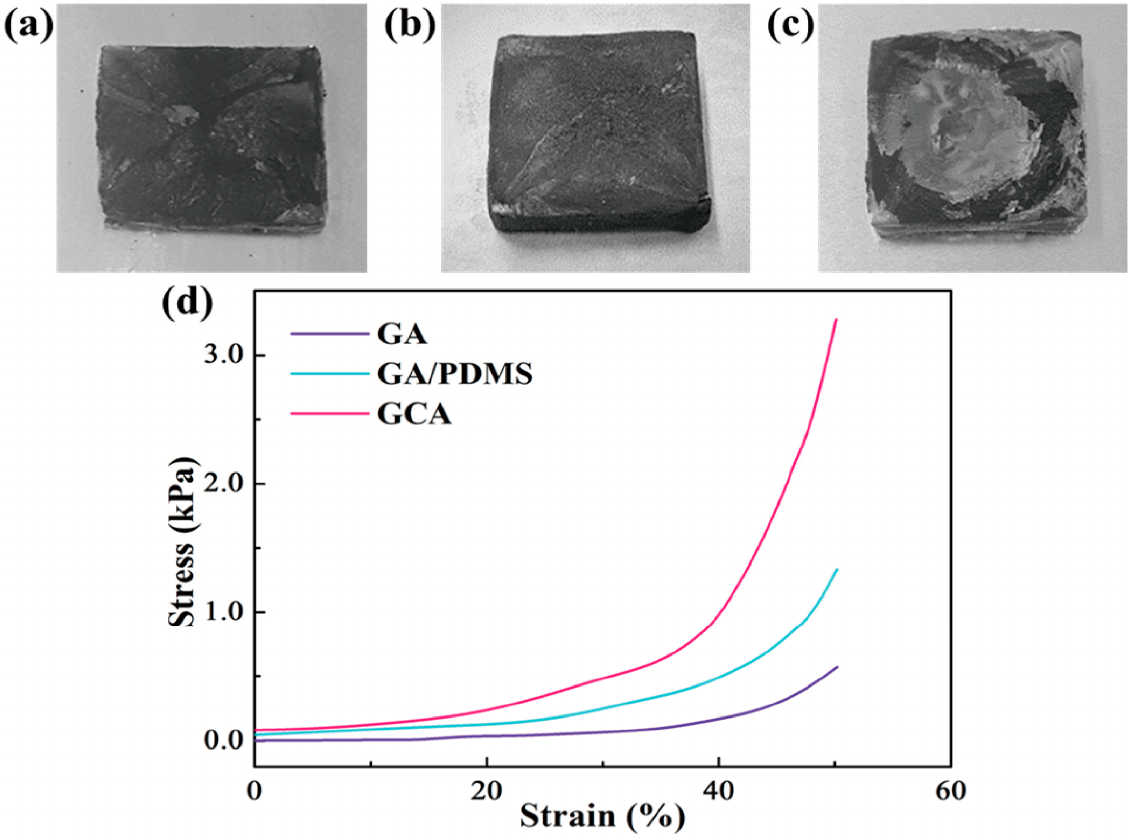
Figure 3. Photographic images of ( a ) graphene aerogel (GA), ( b ) GA/PDMS, and ( c ) GCA. ( d ) Stress– strain curves of the graphene aerogels.